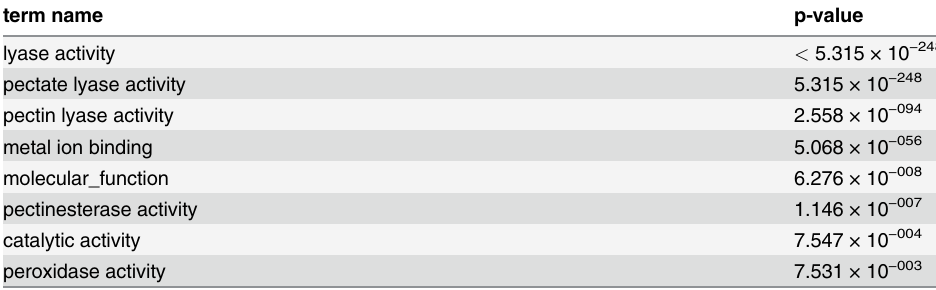
Table 1. Term enrichment p-values for the PL1 Set signi fi cant terms (alpha = 0.01) while using the complete CAZy Collection as